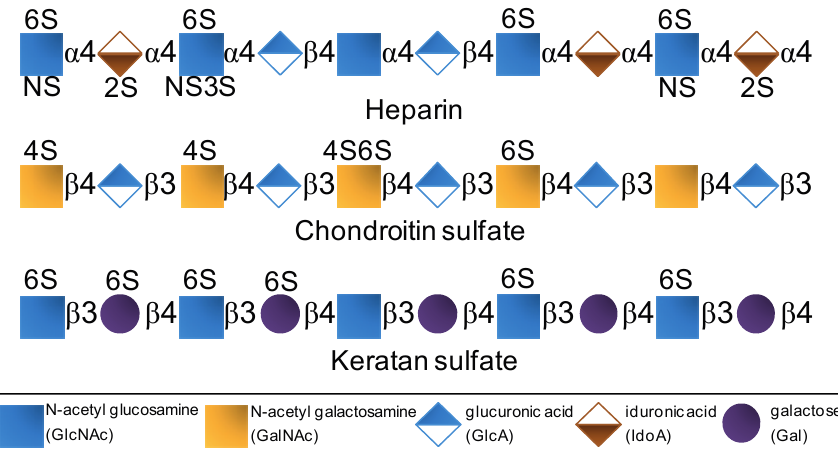
Figure 1. Structural representation of the most explored therapeutic glycosaminoglycans of the global pharmaceutical